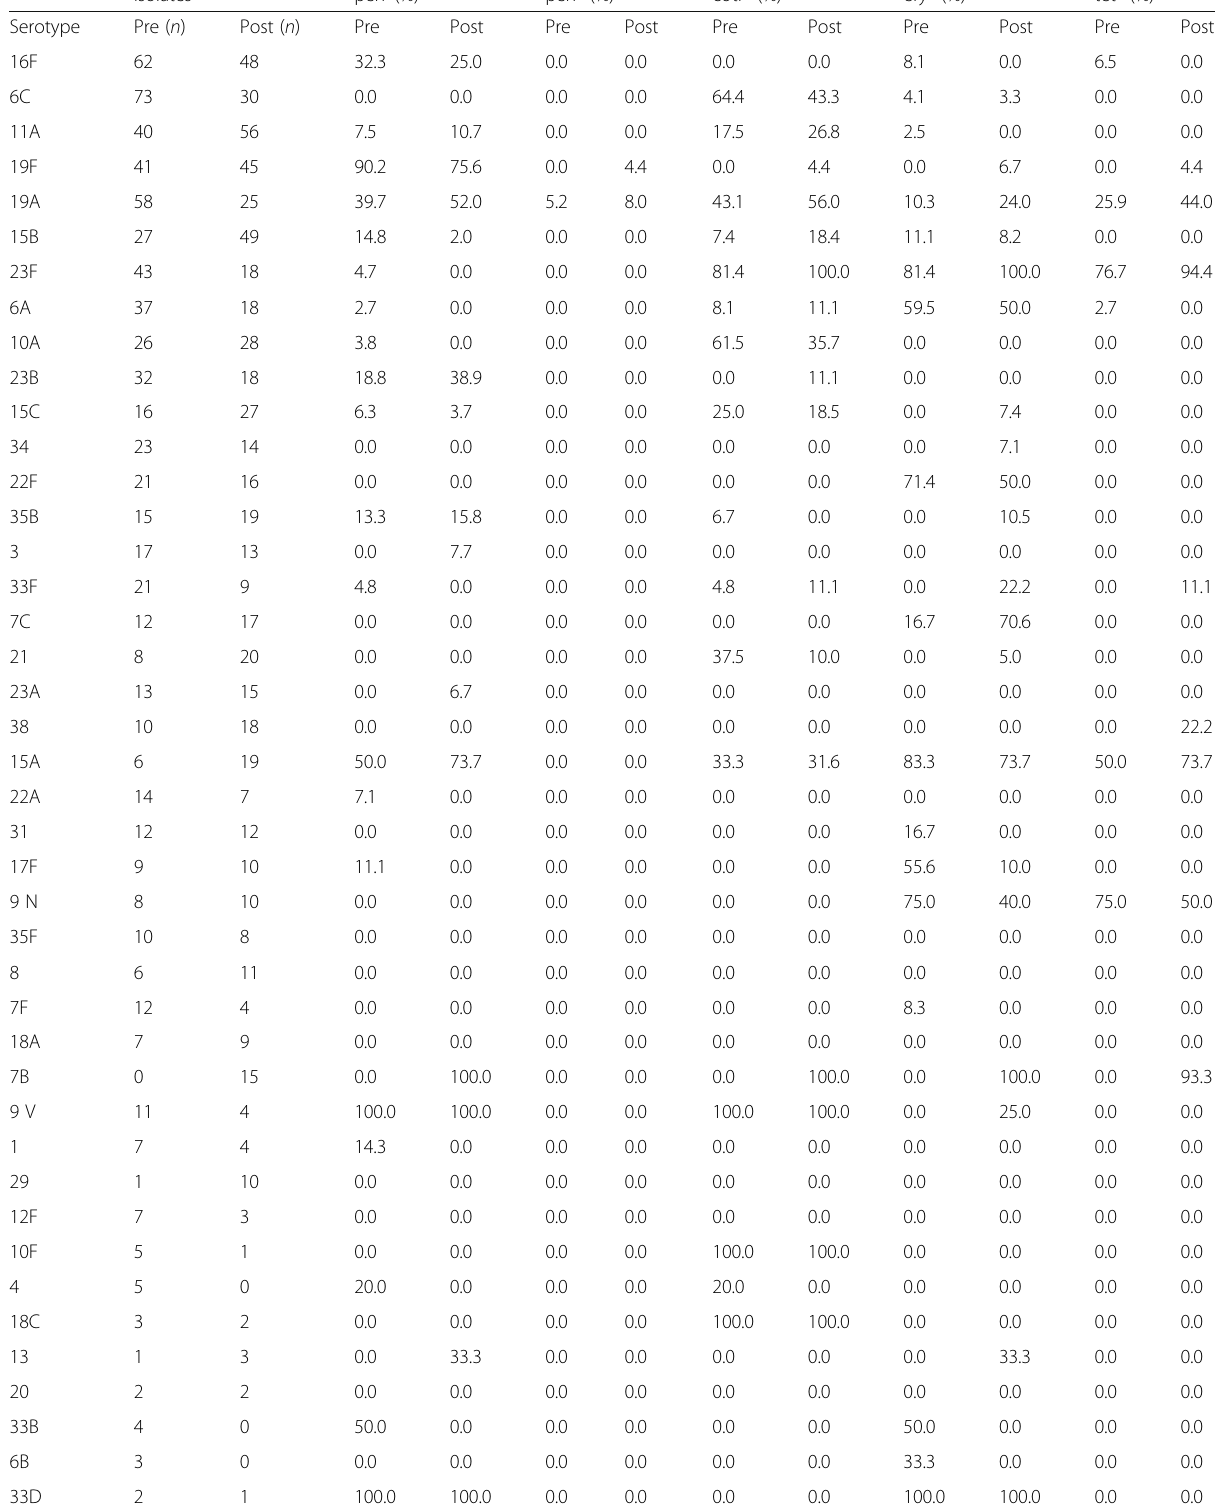
Table 2 Frequencies of serotypes and antibiotic resistance rates found among 1590 isolates of Streptococcus pneumoniae among Aboriginal people in Western Australia, August 2008 – November 2014 . PCV13 was introduced on July 1 2011